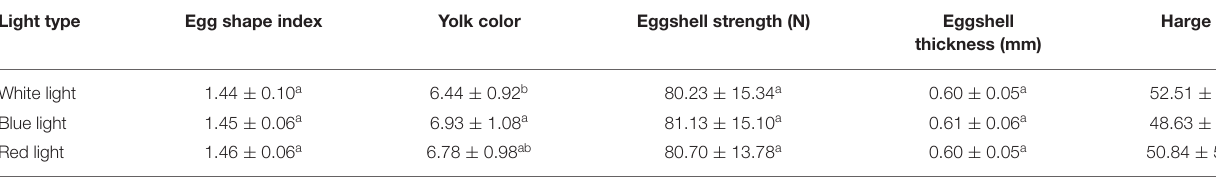
TABLE 5 | Effects of different color light on egg quality of Zi-goose.